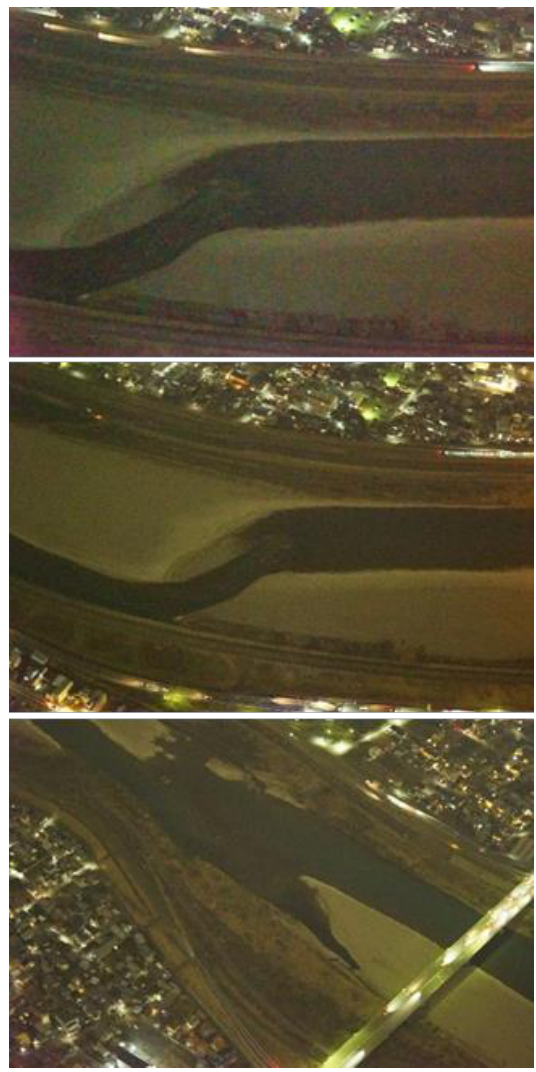
Figure 3. Ultrasensitive camera images. Top: ISO 409600, middle: ISO 102400, bottom: ISO 51200.